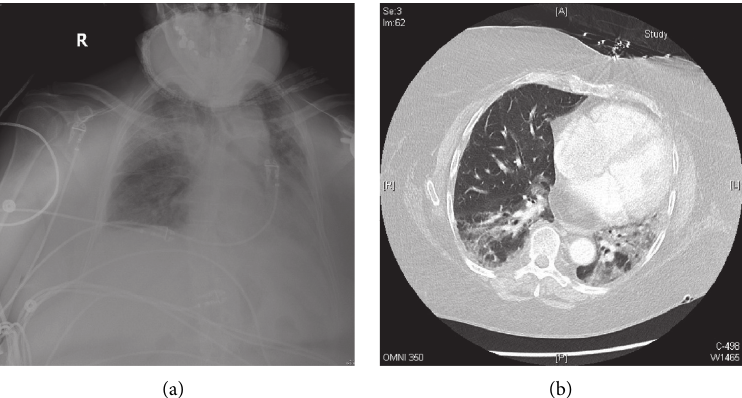
Figure 3: Chest X-ray demonstrating bilateral ground-glass opacities, worse in the right upper lung (a). CTA chest demonstrating pe- ripheral, patchy ground-glass infiltrates, and consolidations, more prominent on the left